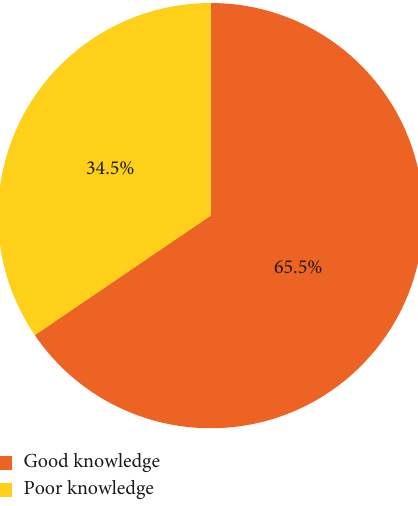
Figure 2: Level of knowledge of kidney disease risk factors among